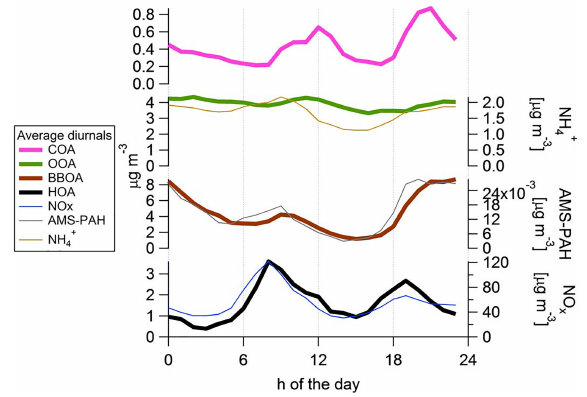
Figure 4. Online-AMS: average diurnal cycles of PMF factors and corresponding